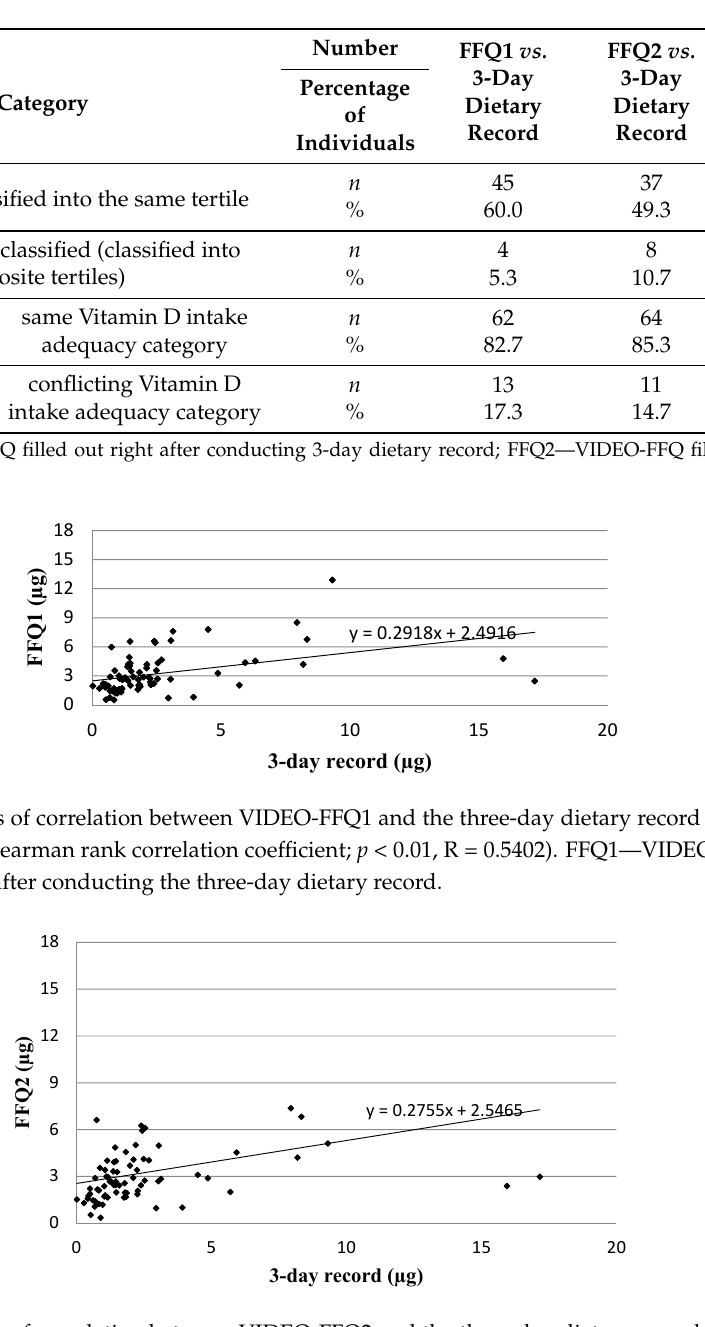
Figure 3. Analysis of correlation between VIDEO ‐ FFQ1 and VIDEO ‐ FFQ2 of Vitamin D daily intake (Spearman rank correlation coefficient; p < 0.01, R = 0.8235). FFQ1—VIDEO ‐ FFQ filled out immediately after conducting the three ‐ day dietary record; FFQ2—VIDEO ‐ FFQ filled out six weeks after FFQ1. The Bland ‐ Altman plot comparing FFQ1 with the three ‐ day dietary record for Vitamin D daily intake is presented in Figure 4. The mean absolute difference of Vitamin D intake was observed to amount to 0.672. The interval from − 5.006 (lower agreement limit) to 6.349 (upper agreement limit)